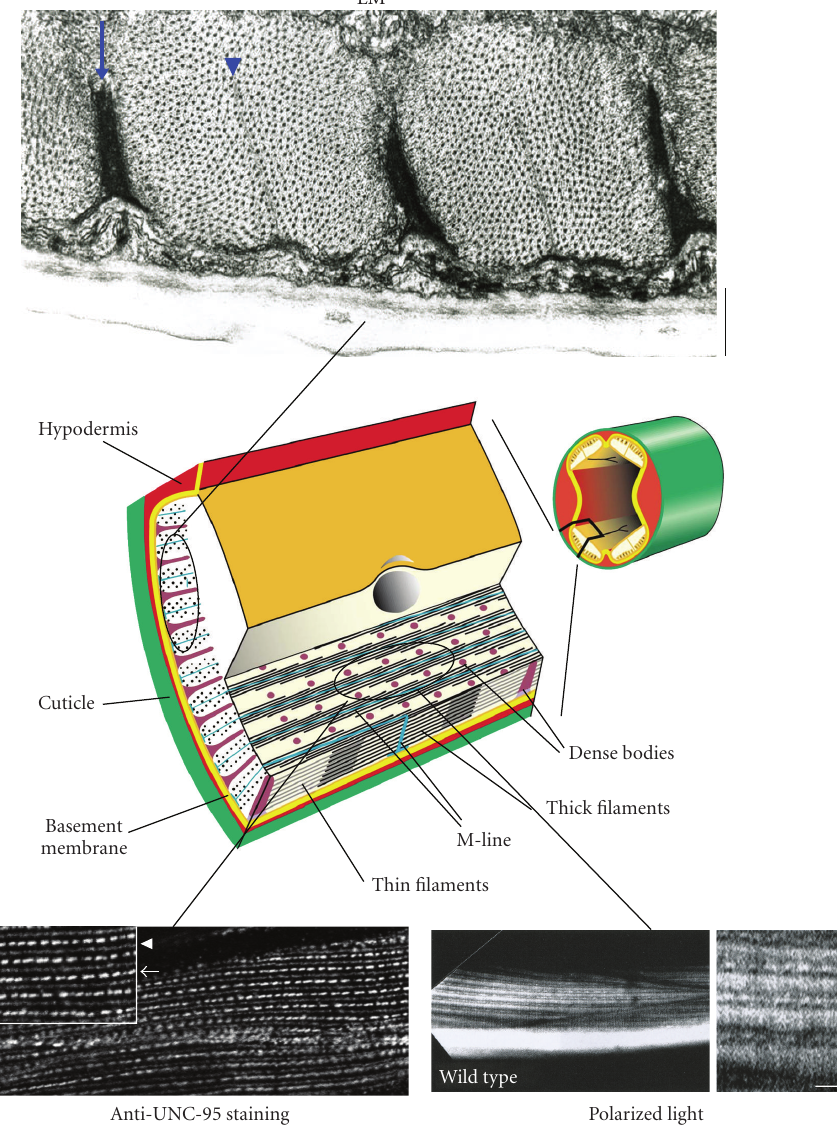
Figure 1: The body wall muscle of C. elegans . The color drawing on the right depicts a cross-section through an adult nematode emphasizing that the body wall muscle is organized into four quadrants. Each quadrant consists of interlocking pairs of mononuclear spindle-shaped cells (23 or 24 per quadrant). In the enlargement, notice that the myofilament lattice is restricted to one side of the cell, rather than filling the entire cross-sectional area as in a vertebrate striated muscle cell. Several planes of section are depicted; one of which emphasizes that fundamentally this is striated muscle with typical A-bands containing thick filaments organized around M-lines, and overlapping thin filaments attached to the Z-disk analogs called dense bodies. Note the plane parallel to the paper; this is the plane viewed when an animal, lying on a glass slide, is examined by light microscopy. At the bottom right is a typical image obtained with polarizing optics showing that bright A-bands alternate with dark I-bands; in the enlargement (right), the cross-sections of the dense bodies can be seen in the I-bands. At the bottom left is a typical image obtained by immunofluorescence microscopy using an antibody to UNC-95 [6] (enlargement is shown at the top left); notice that UNC-95 localizes to both rows of dense bodies (arrow) and M-lines (arrowhead). In the large drawing, the plane of section shown on the left side is a true cross-section through the nematode and through a body wall muscle cell; at the top of the figure is a typical transmission EM view of two sarcomeres; an arrow marks a dense body and an arrowhead marks an M-line. In the EM, at the bottom is located the thick cuticle and thin hypodermal cell and basement membrane; the cross-sections of thick filaments in the A-bands and the cross sections of the thin filaments in the I-bands (surrounding the dense bodies) can be seen. Notice that in the drawing and in the EM, all of the dense bodies and the M-lines are anchored to the muscle cell membrane. Indeed, the EM reveals that there is electron dense material at the base of each dense body and M-line that is likely to be responsible for this anchorage. This is in contrast to vertebrate striated muscle in which only the peripherally-located sarcomeres are anchored to the muscle cell membrane through costameres at the level of the Z-disks and possibly the